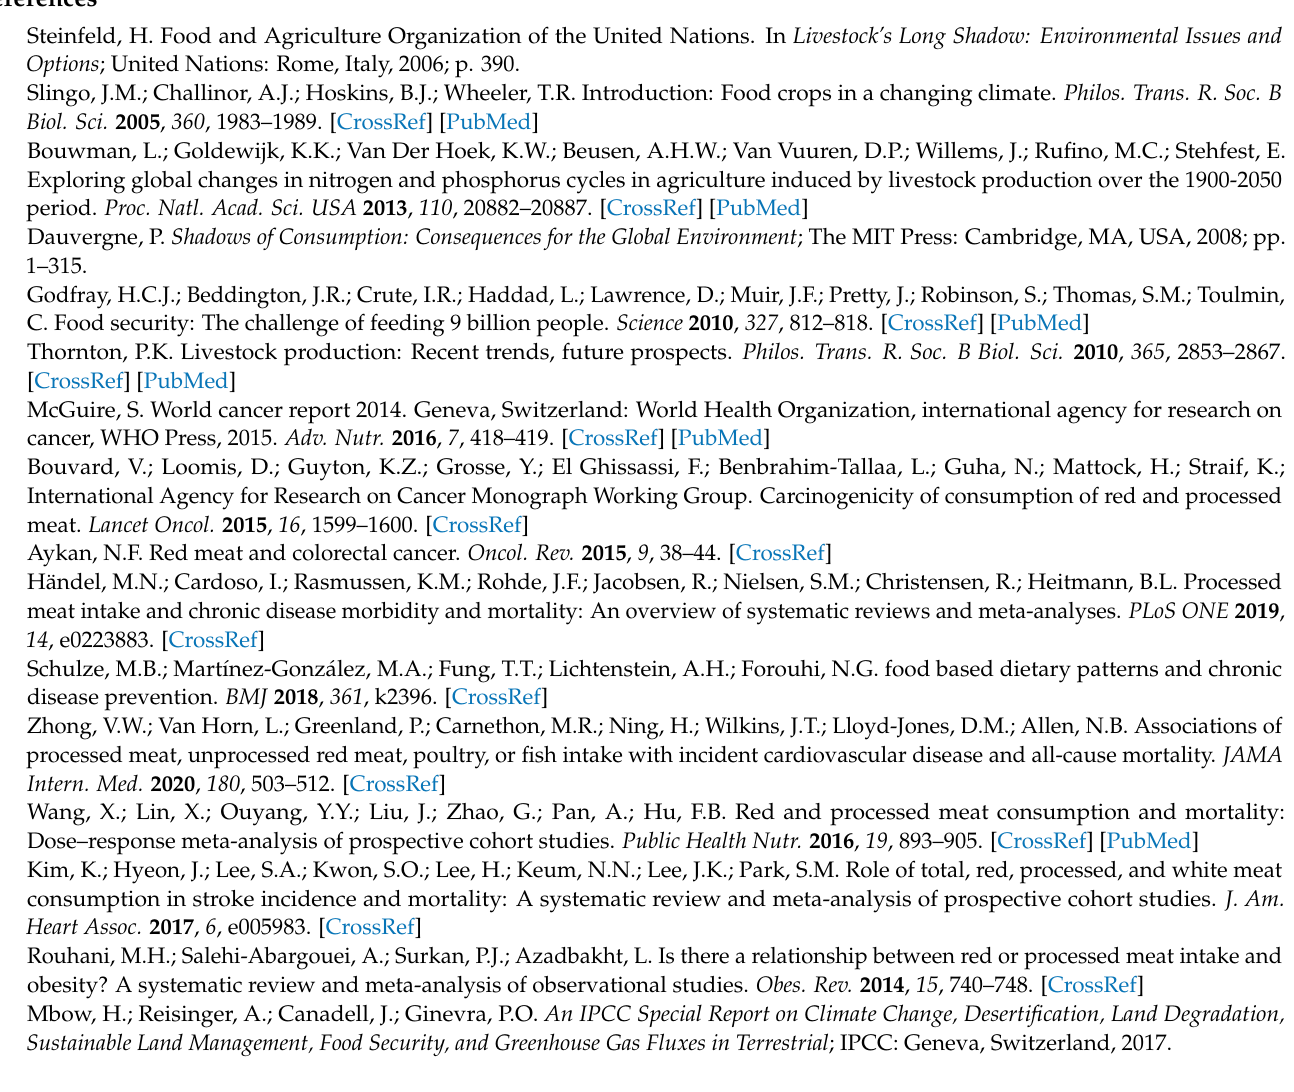
Figure A3. PRISMA 2009 Flow Diagram—Change [85]. For more information, visit www.prisma- statement.org.